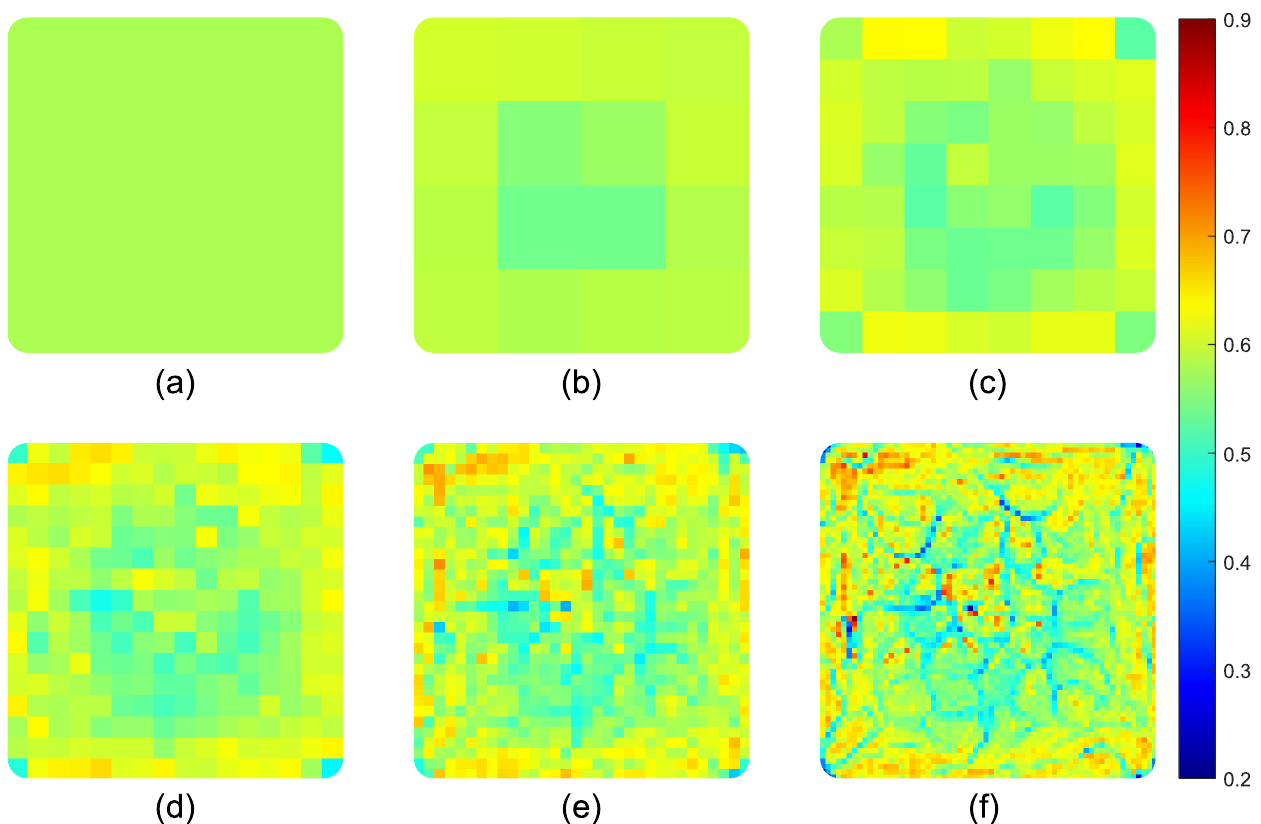
Figure 5. V f distribution through the cross-section for various RVE sizes; ( a ) uniform, ( b ) ‘Case A’ (4 × 4), ( c ) ‘Case B’ (8 × 8),